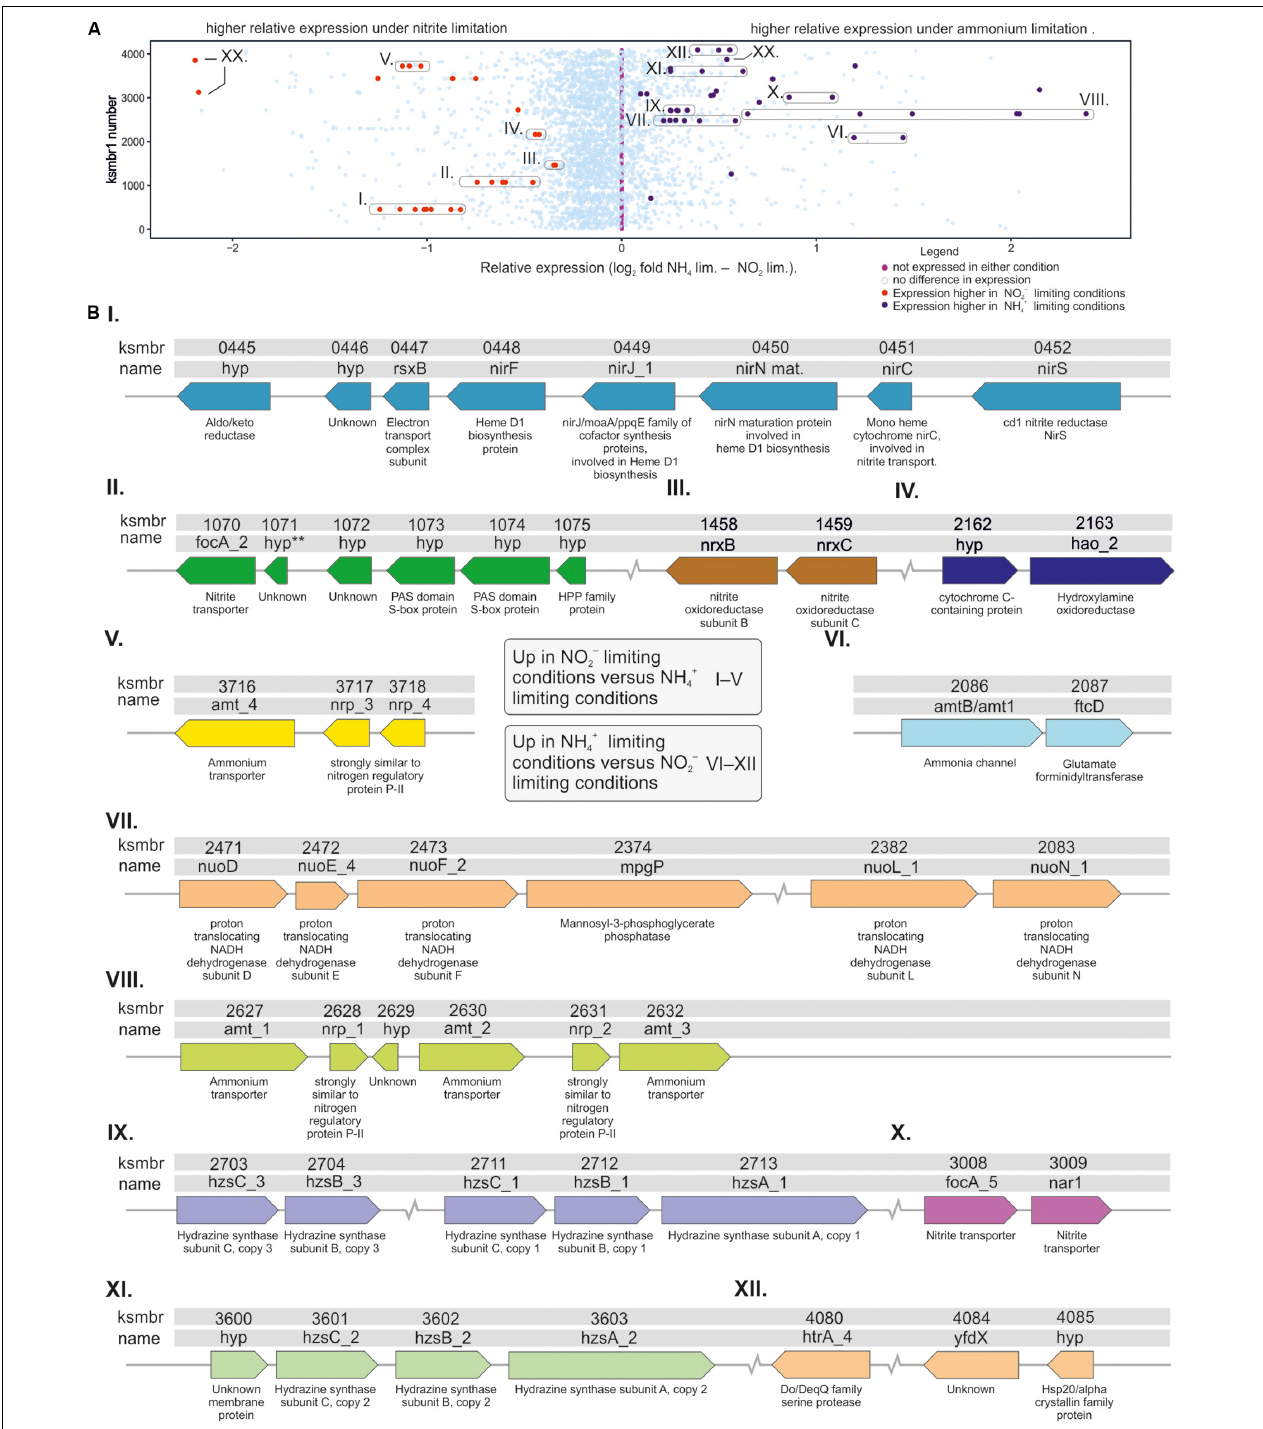
FIGURE 2 | Schematic representation of K. stuttgartiensis MBR1 genes that are either up- or downregulated in response to ammonium- or nitrite-limiting bioreactor growth conditions. (A) graph showing all genes as dots on vertical line, with the relative expression on the y-axis. Genes indicated in translucent blue were either not significantly expressed, or not significantly different between the two conditions. Genes indicated in purple were expressed at a significantly higher level in response to ammonium limitation compared to nitrite limitation. Genes indicated as red dots were expressed at a significantly higher level in response to nitrite limitation when compared to ammonium limitation. Circles were drawn around genes that are in very close genomic proximity. XX = KSMBR1_3177, KSMBR1_3122, and KSMBR1_3846. (B) Synteny and description of genes that were expressed at a significantly different level between nitrite- and ammonium-limiting conditions. Roman numerals I–V indicate genes that were expressed relatively more during nitrite-limiting conditions, and roman numerals VI–XII indicate genes expressed relatively more during ammonium-limiting conditions.